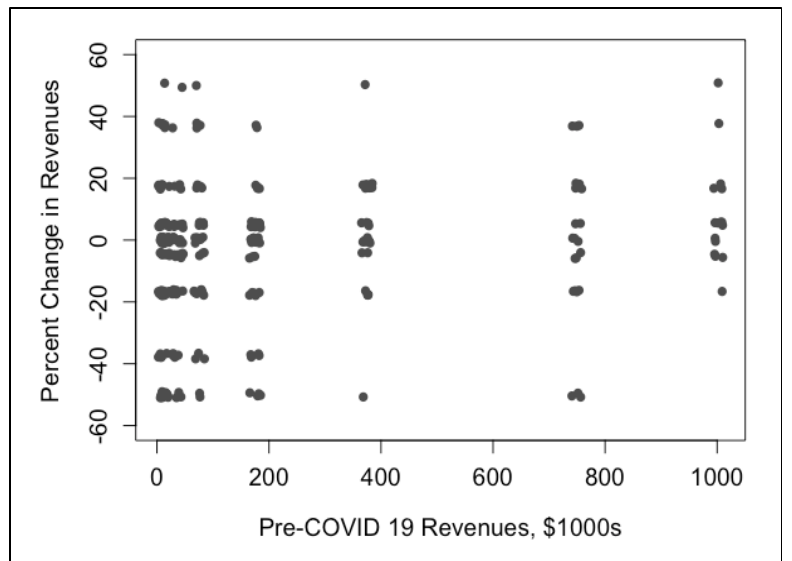
Figure 2. Correlation Between Typical Pre – COVID- 19 Annual Revenues and Percent Change in Annual Revenues for 2020 a